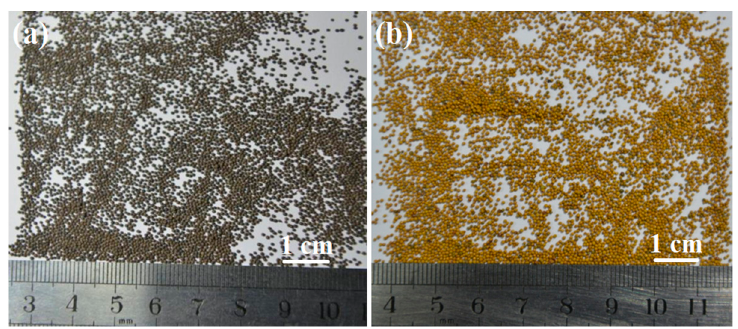
Figure 6. Ceramic ( a ) and coated ceramic ( b ) proppant. Table 5. Properties of polymer coated synthetic ceramic proppant.